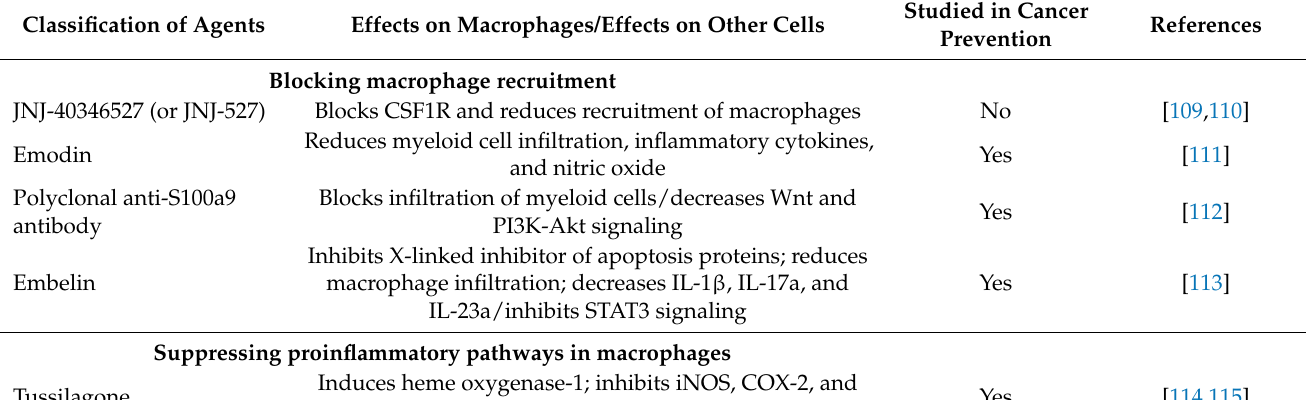
Table 2. Selected agents targeting